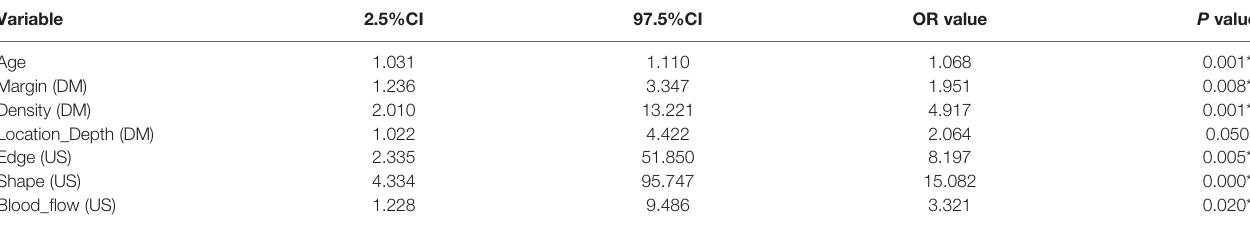
TABLE 3 | Positive results of univariate analysis for the differential diagnosis of round-like breast tumors. Variable